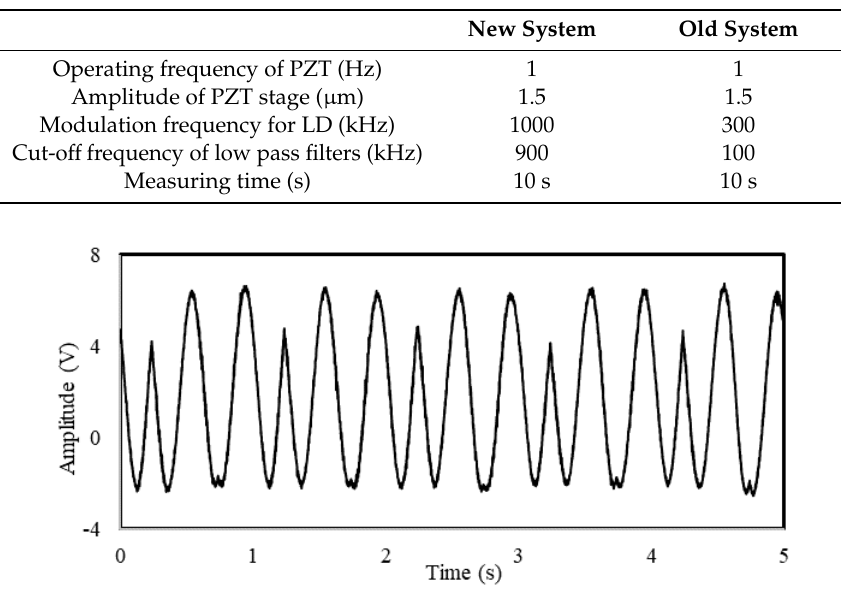
Figure 6. Interference signal of the displacement-measuring interferometer.